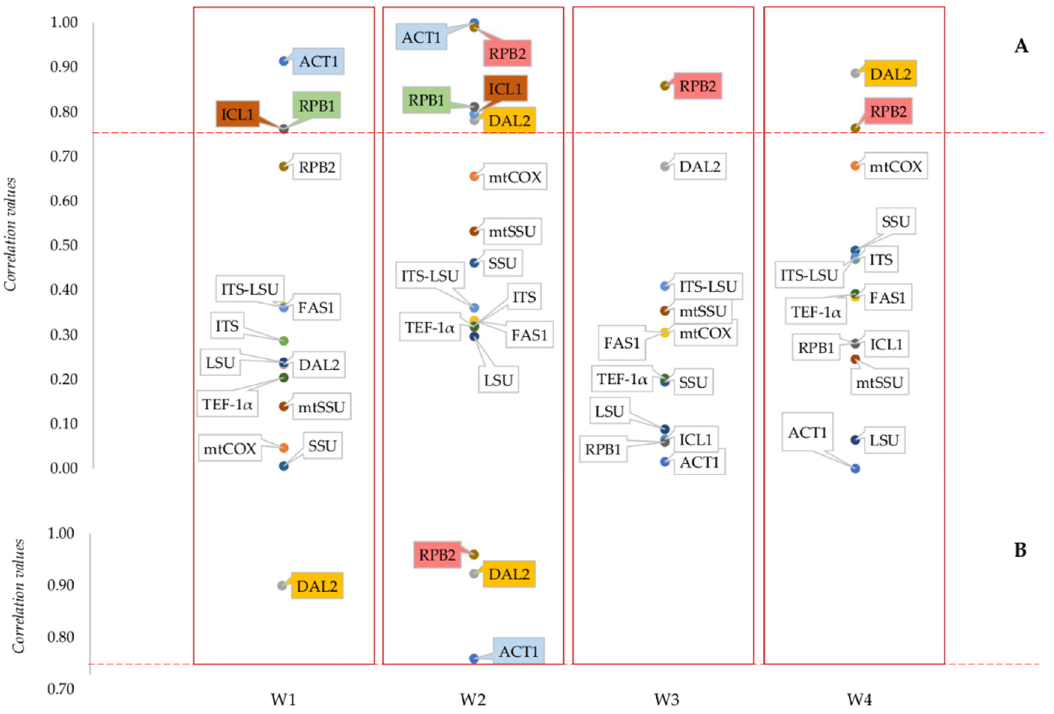
Figure 4. Correlations between taxonomic markers and characteristic spectral regions of the FTIR spectrum of both control and stressed cells. Maximum correlation values between each taxonomic marker and fatty acids (W1), amides (W2), mixed (W3) and carbohydrates (W4) spectral areas are reported for both control ( A ) and stressed ( B ) cells. The latter analysis was carried out grouping together data from the three stressing conditions tested. Colored labels refer to markers displaying correlation values higher than 0.75 threshold, represented by the red dashed lines. Maximum correlation values of each marker with the four IR regions are reported and quartiles thresholds are indicated as horizontal dashed lines. ICL1 , RPB1 and ACT1 showed relatively high correlation values (0.76 for the first two and 0.91 for the third) with fatty acid (W1) region of control samples, followed by RPB2 , placed just below 0.70. All the other markers showed lower correlation values, always below 0.40 (Figure 4A). The same four marker, together with DAL2 , were highly correlated also with amides (W2) region of control samples. Only RPB2 and DAL2 maintained a high correlation value with mixed (W3) and carbohydrates (W4) region, despite being the second marker slightly below 0.70 in W3 region; all the other markers showed correlation values around 0.5 or